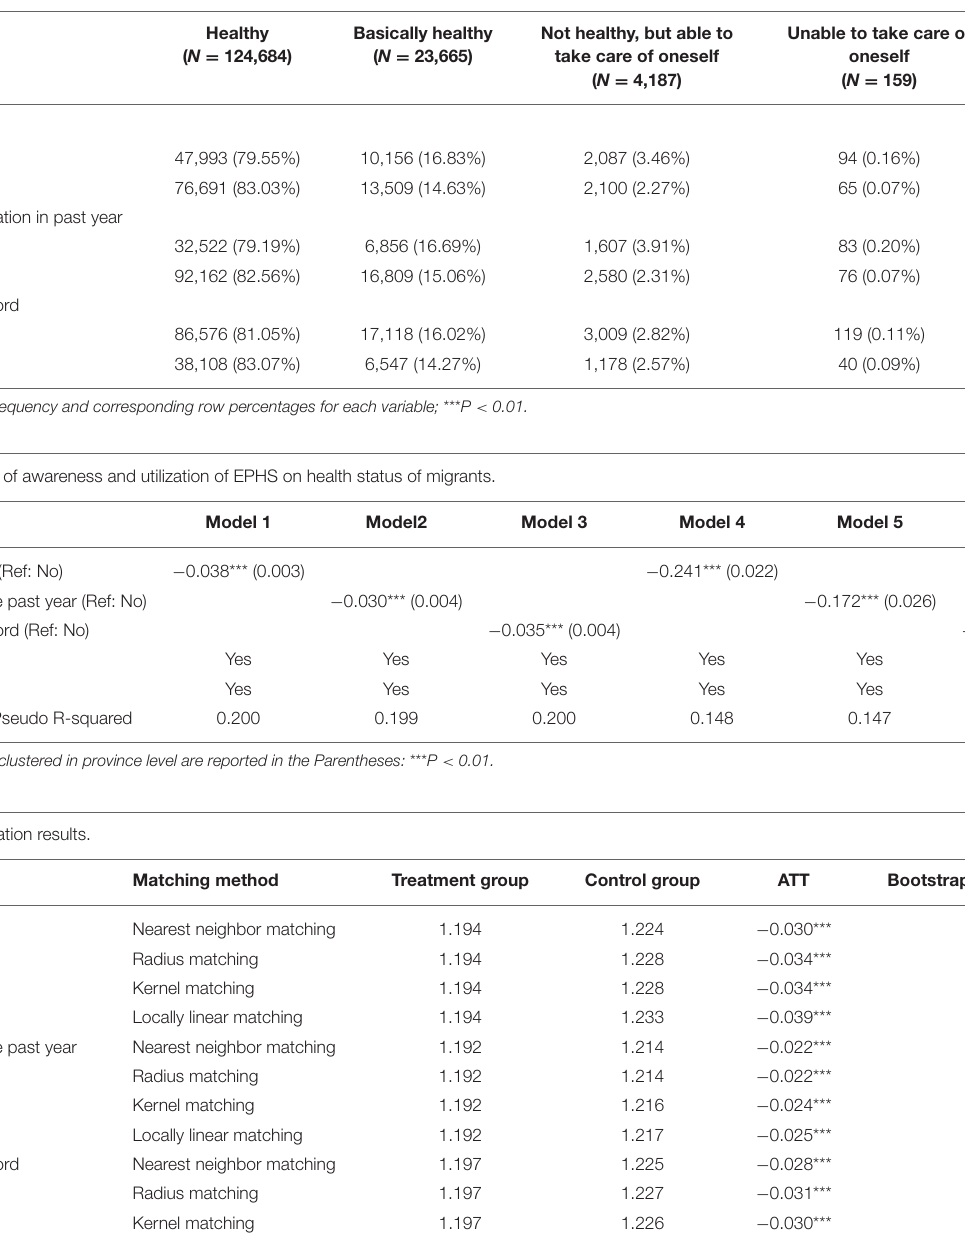
TABLE 2 | Self-rated health among different subgroups of awareness and utilization of NEPHS.